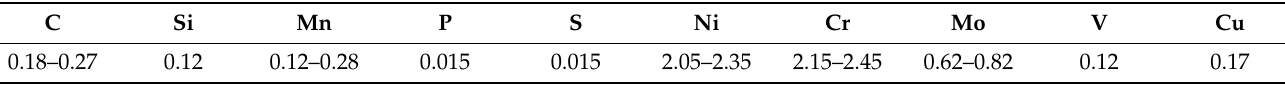
Table 2. Chemical composition of BM